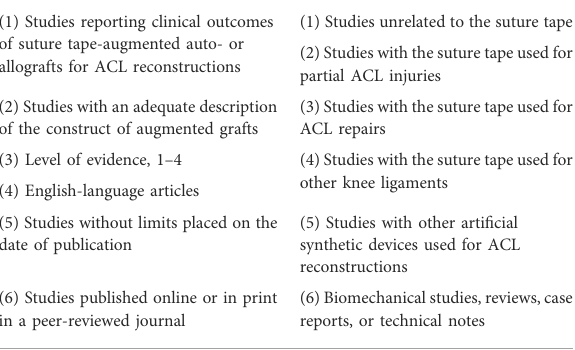
TABLE 1 Study inclusion and exclusion